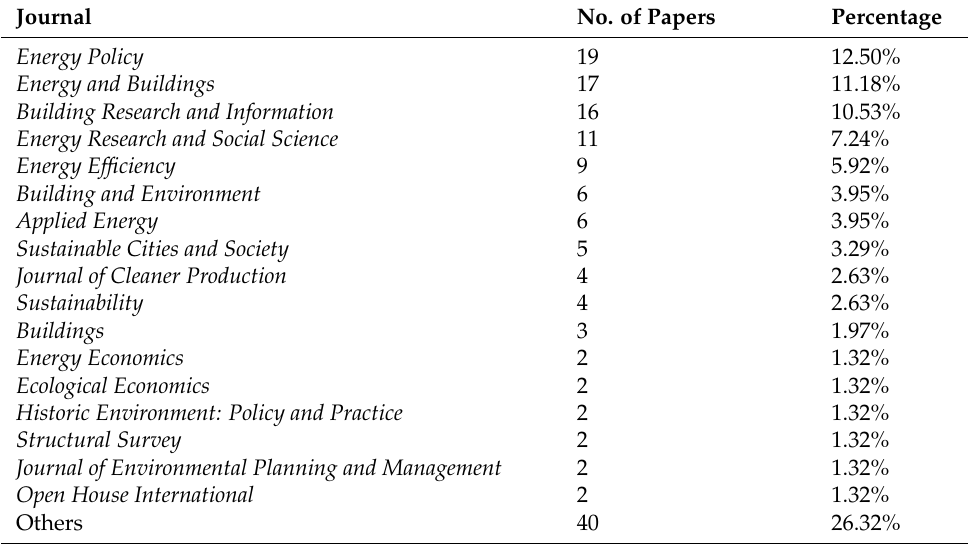
Table 1. Distribution of collected papers in